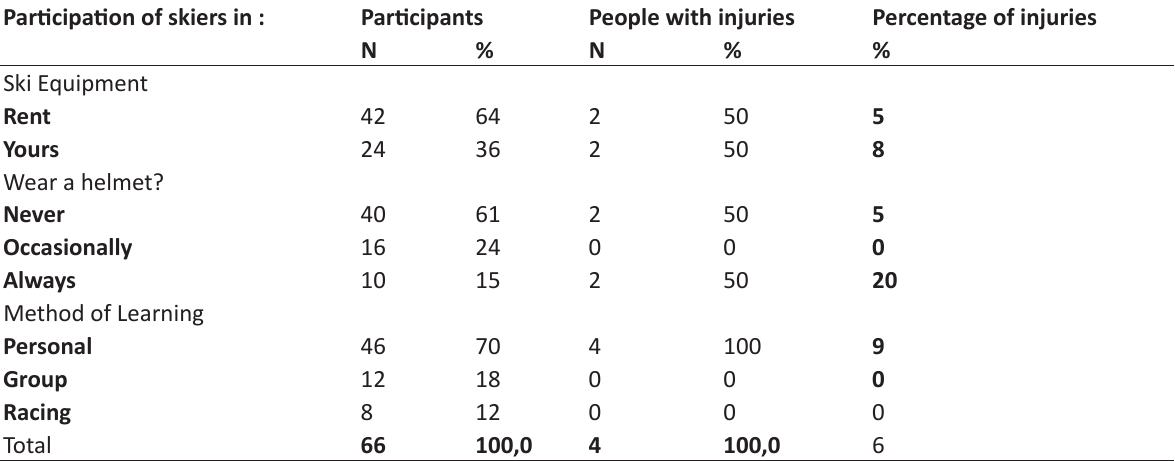
Table 3. Involvement of skiers: the physical condition before the season, in warming up and corrective exercises Participation of skiers in : Participants People with